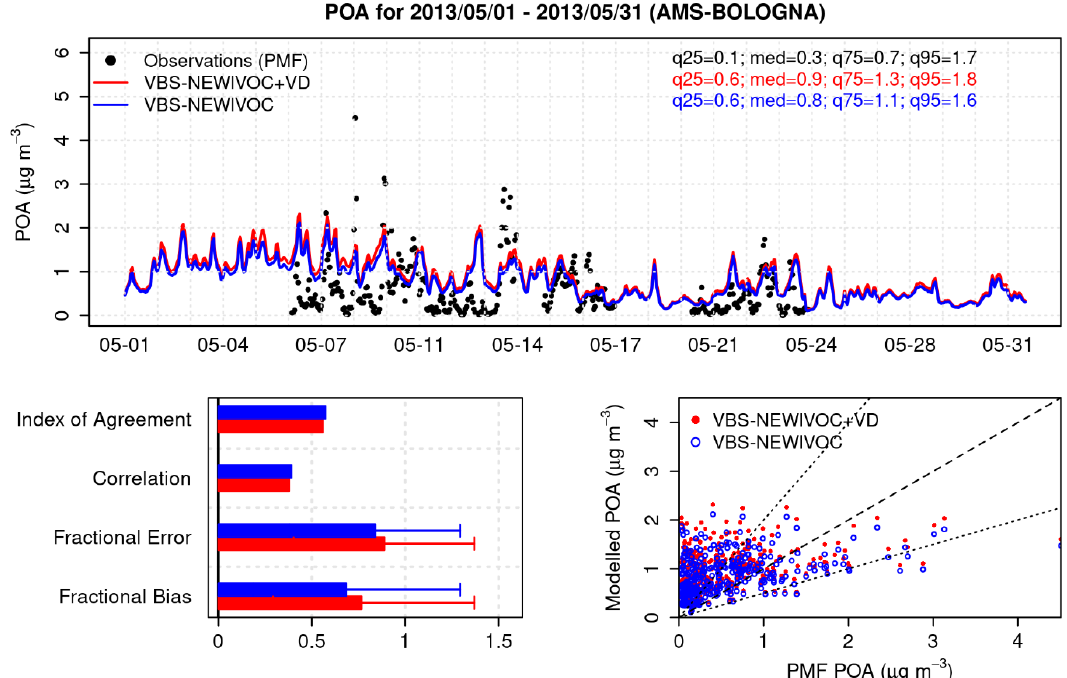
Figure 12. Comparison among modeled and observed (PMF results, black) POA concentrations in May 2013 at the Bologna site: VBS scheme with new parameterizations for IVOC emissions (VBS_NEWIVOC, blue) and VBS scheme with new parameterizations for IVOC emissions and revised volatility distribution (VBS-NEWIVOC+VD, red).